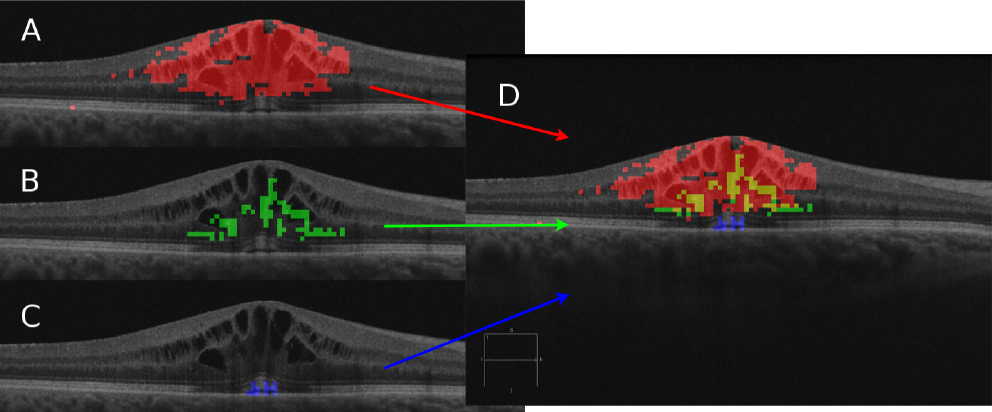
Figure 1. The three individual DME detections and the final merged pathological map. ( A ) CME in red. ( B ) DRT in green. ( D ) SRD in blue. ( D ) Global color